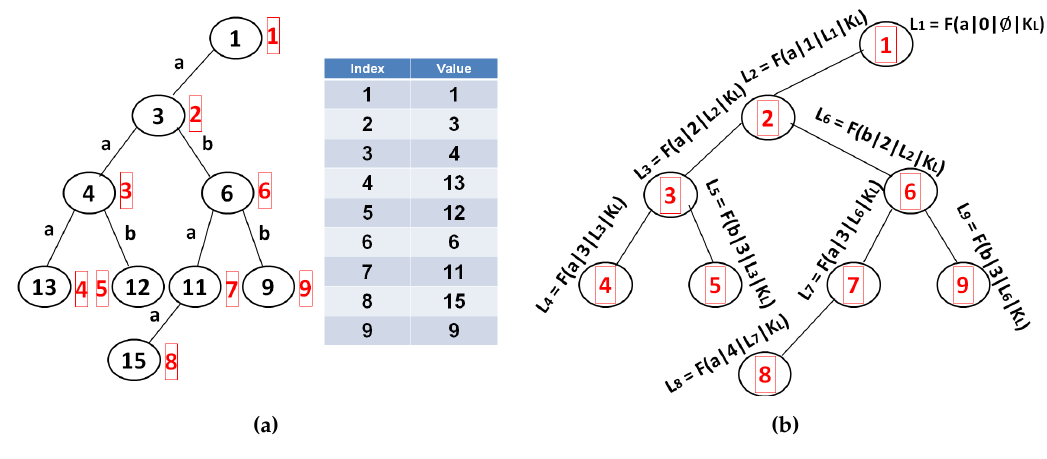
Figure 4. Construction of a searchable index. ( a ) An example of position array Y ; ( b ) an example of the path label encryption of position heap